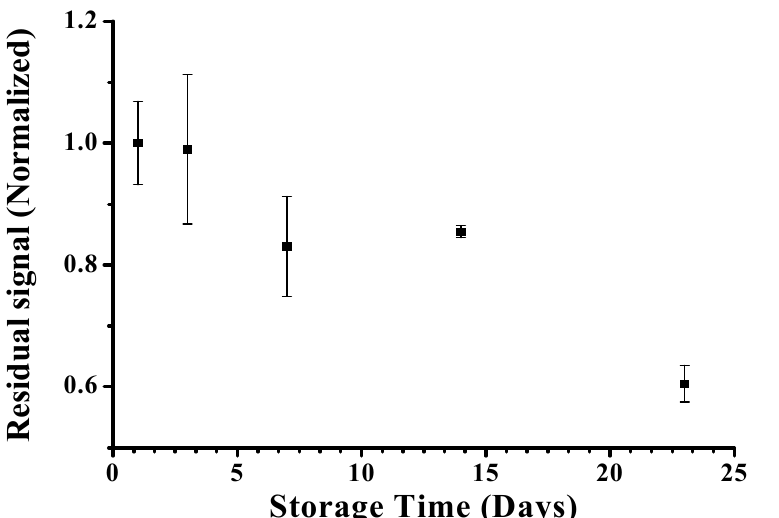
Figure 12. Thermal fading behavior of MgB 4 O 7 :Zn glass S35654.